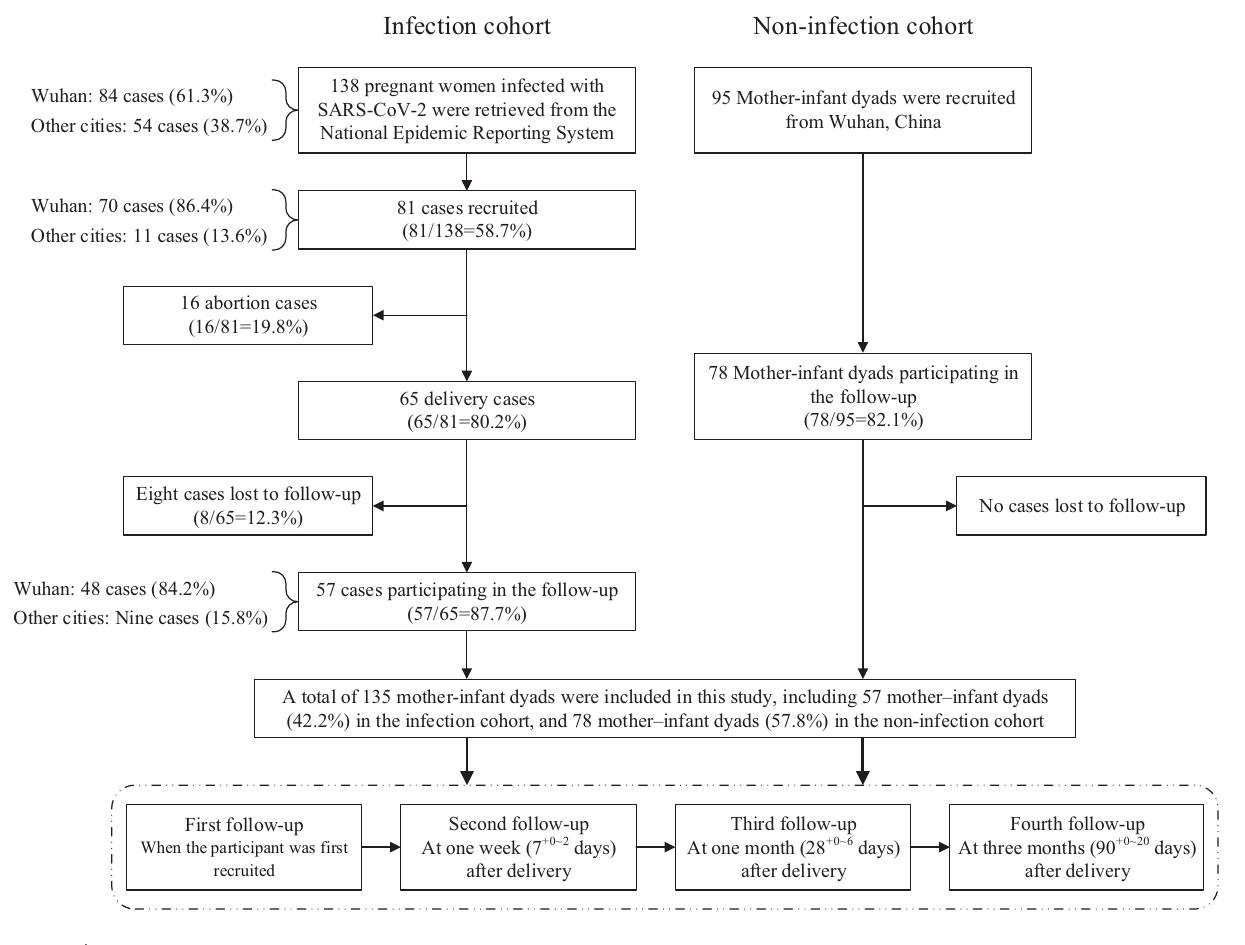
FIGURE 1 | Flowchart of the prospective cohort